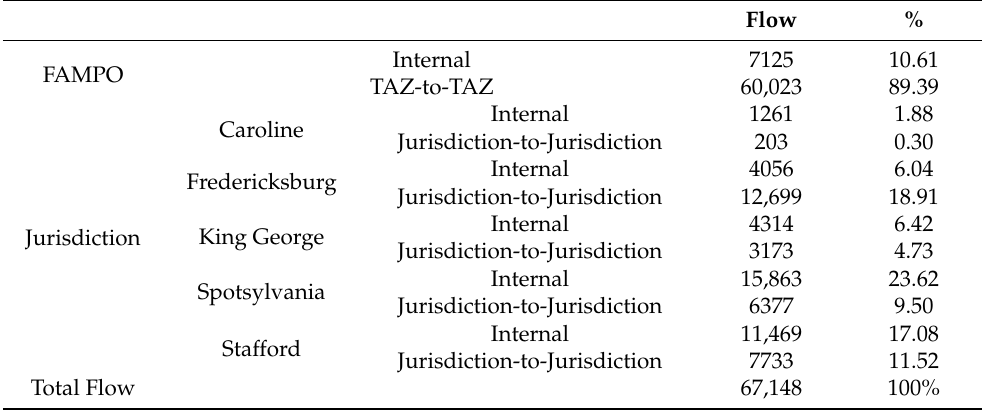
Table 2. Commuting Flows (Number of Commuters) in 2000.